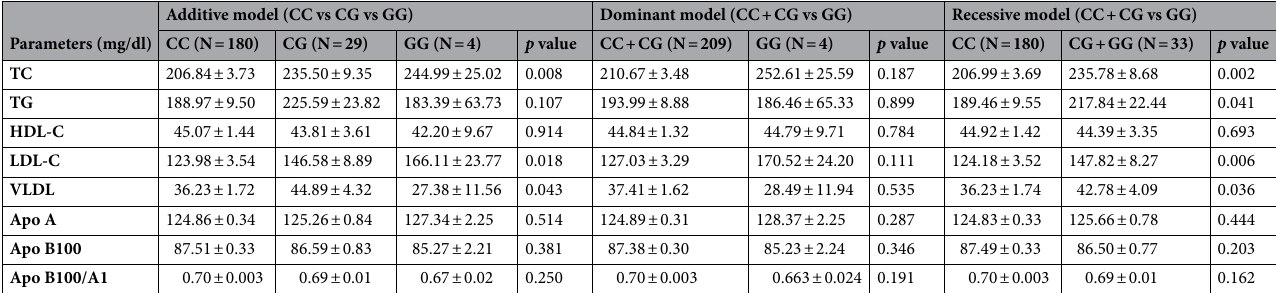
Table 3. Comparison of lipid profile and apolipoprotein levels between the diabetic individuals using different genotype models. * P value ≤ 0.05 was considered statistically significant.